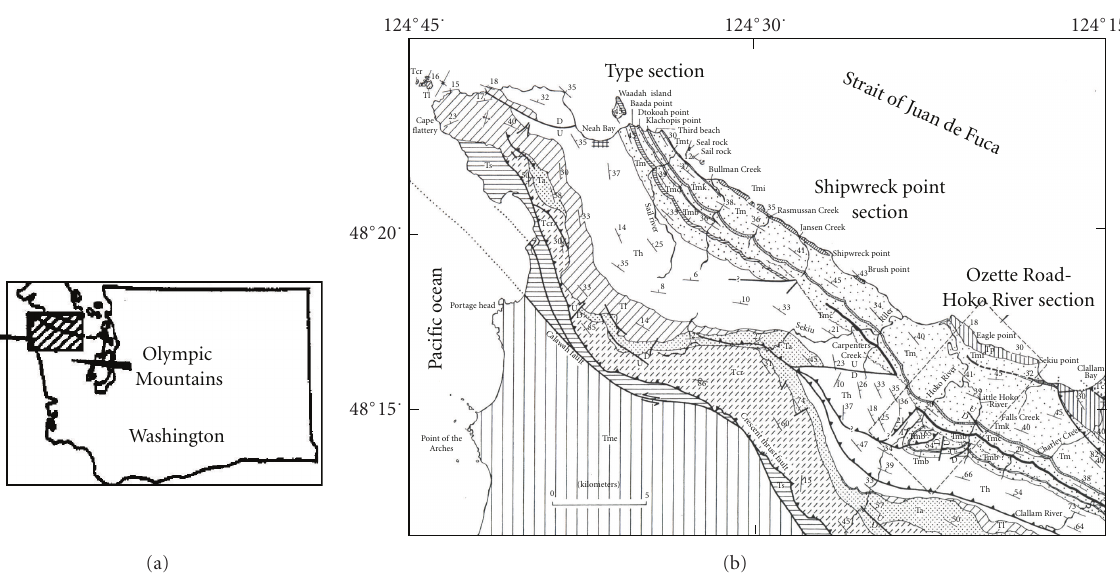
Figure 1: (A) Index map showing location of study in the northwest Olympic Peninsula. Modified from Snavely et al. [8, Figure 1]. (b) Geologic map of the northwest Olympic Peninsula, showing the location of the sections mentioned in this paper. Stippled outcrop pattern (Tm) indicates the Makah Formation, and its various named members (Tmb = Baada Point Member; Tmd = Dtokoah Point Member; Tmc = Carpenters Creek Member; Tmk = Klachopis Creek Member; Tmj = Jansen Creek Member). Unshaded outcrop = Hoko River Formation (Th symbols). Other formations: Tc = Clallam Formation (open circle pattern); Tp = Pysht Formation (vertical line pattern); Tl = Lyre River Formation (diagonal line pattern); Ta = Aldwell Formation (fine stipple pattern); Tme = m´elange (wide vertical line pattern); Ts = lower sandstone and siltstone (horizontal line pattern); Tcr = Crescent Formation (basal volcanic unit). Modified from Snavely et al. [8, Figure